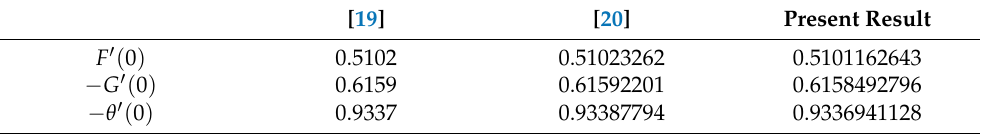
Table 3. A link table between [19,20] with the current problem on fixed Pr = 6.5 and M = 0 = γ = R = s = β = Rd = δ =